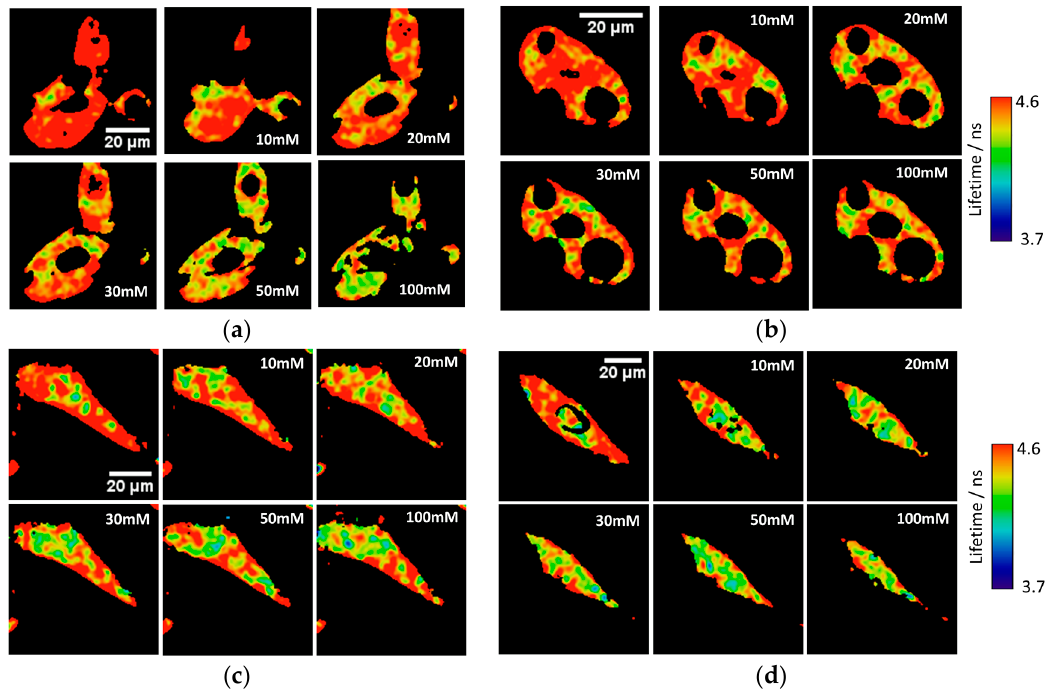
Figure A2. Other representative examples of the variation of the phosphate response of the released 2Me-4OMe-TM in FLIM imaging in ( a , b ) Hep2G and ( c , d ) MC3T3-E1 cells, permeabilised with α -toxin and different extracellular phosphate concentrations.